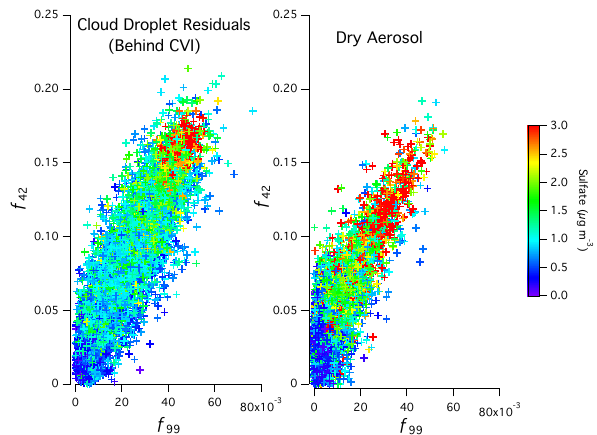
Fig. 13. Variation of the organic fraction of m/z 42 and m/z 99 ( f 42 , f 99 ) in the organic spectra of cloud water droplet residuals and dry aerosol. Markers are colored by sulfate loading to illustrate the potential impact of ships on each